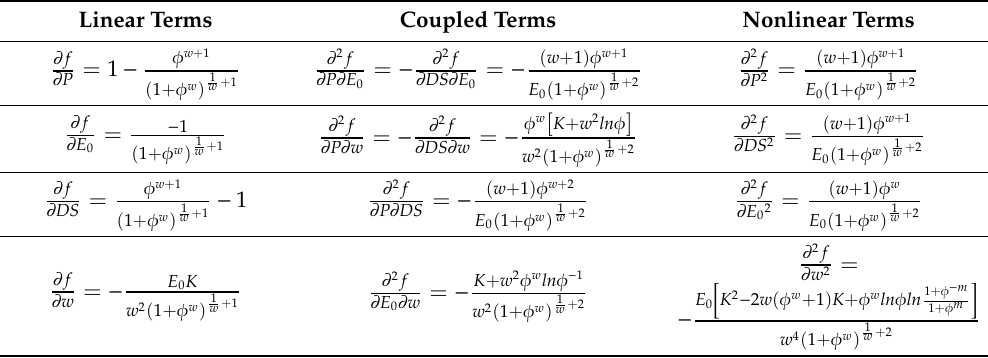
Table 1. Expressions of di ff erent partial